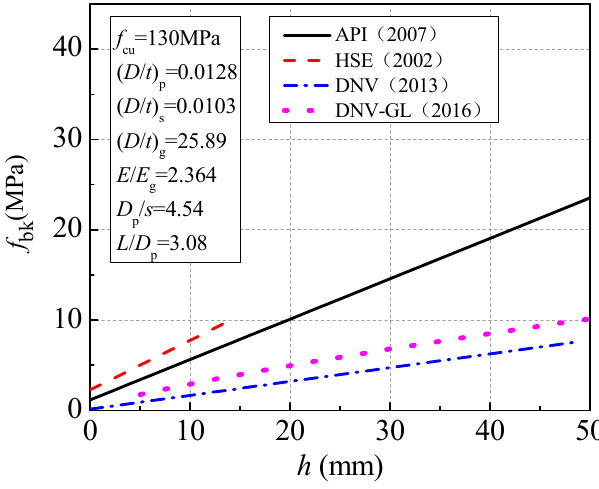
Figure 3. Relationship between interface shear strength ( f bk ) and shear key height ( h ).